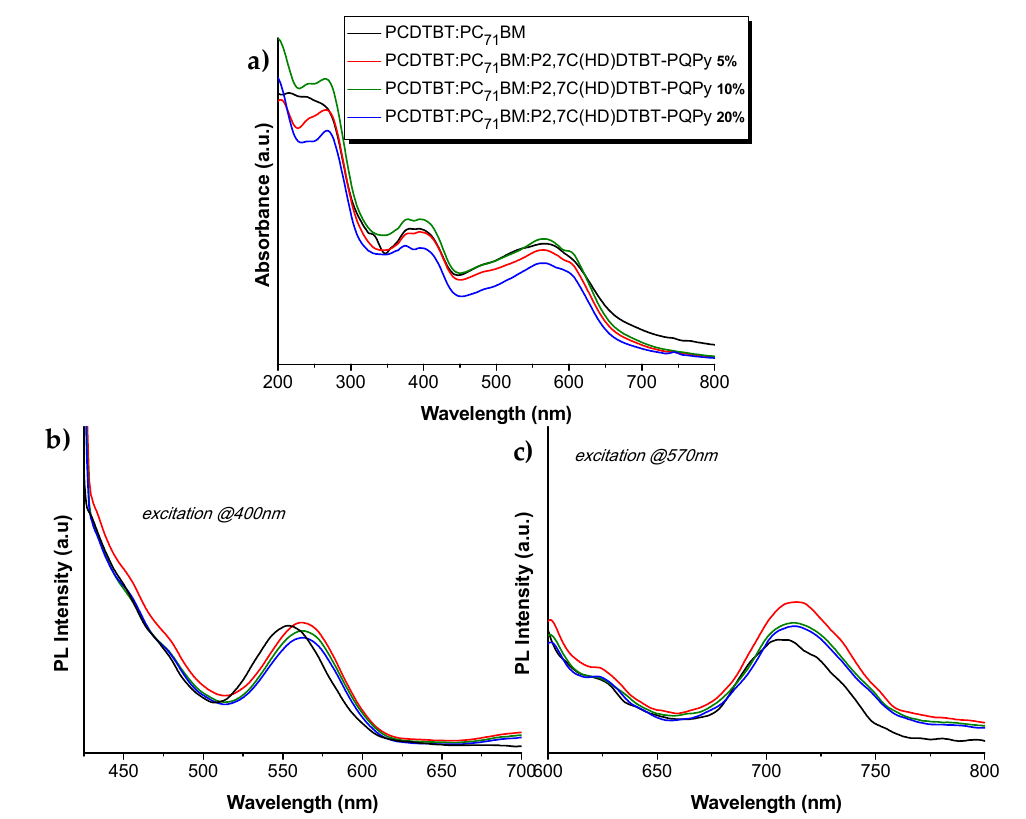
Figure 6. ( a ) UV-Vis specta; ( b ) PL spectra upon excitation at 400 nm; and ( c ) PL spectra upon excitation at 570nm of the PCDTBT:PC 71 BM:P2,7C(HD)DTBT-PQPy blends of spin-coated films.